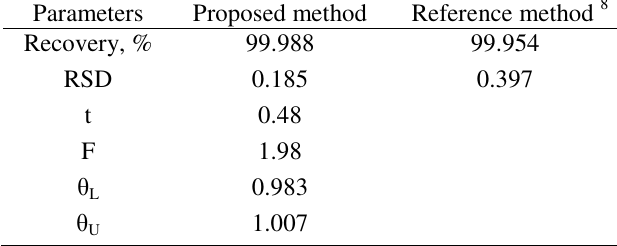
Table 4. Assay results of flucloxacillin using the proposed method and reference method 8